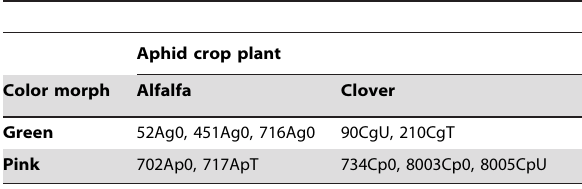
(Table 1). Along with crop plant of origin and color morph, aphids